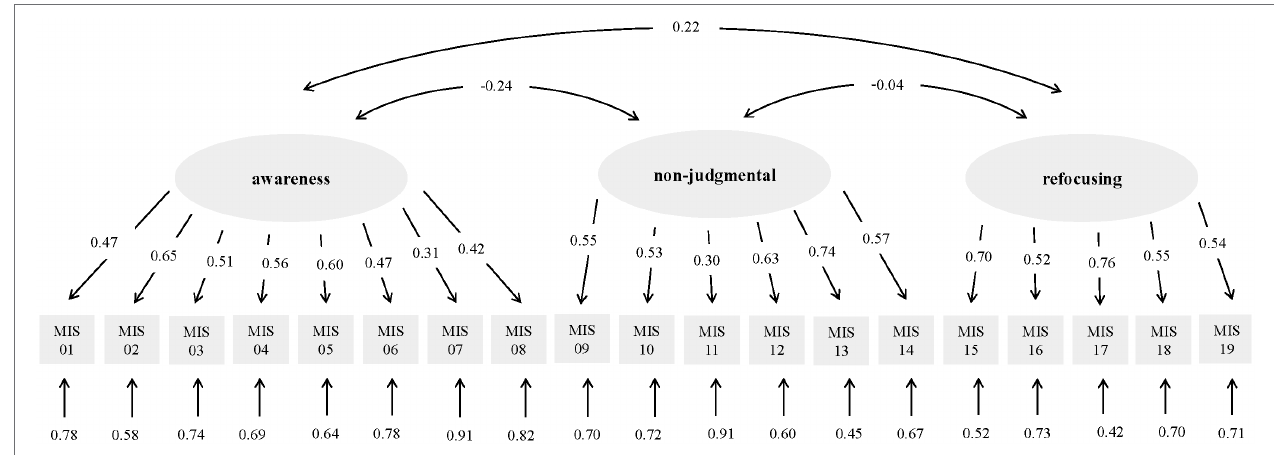
FIGURE 1 | Factorial validity of the MIS-D (German translation). Results of the confirmatory factor analysis (standardized